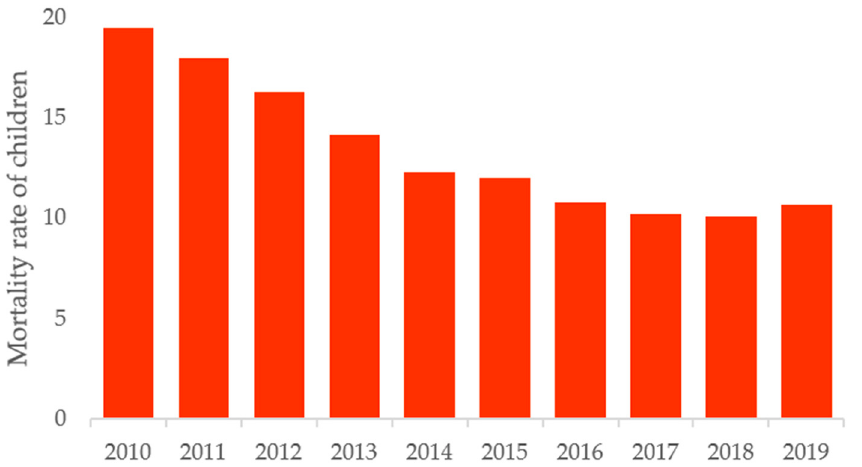
Figure 2. Bureau of National Statistics of the Agency for Strategic Planning and Reforms of the Re- public of Kazakhstan. Available online: https://stat.gov.kz/ (accessed on 26 May 2021).